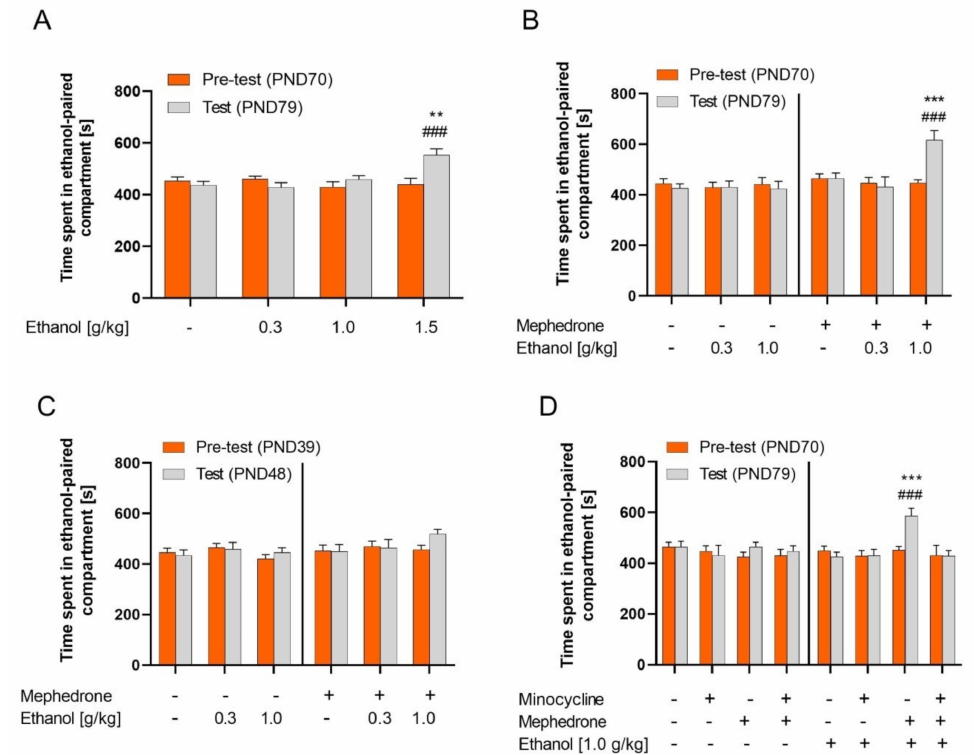
Figure 1. Effect of mephedrone and minocycline pretreatment on rewarding effect of ethanol mea- sured in the CPP test. The data obtained in the CPP test are expressed as time in seconds (s) spent in the ethanol-paired compartment ± SEM in the pre-test and test. ( A ) Ethanol (1.5 g/kg, n = 7–8/group) alone induced CPP in adult (PND79) rats; ** p < 0.01 vs. EtOH 1.5 g/kg, pre-test; ### p < 0.001